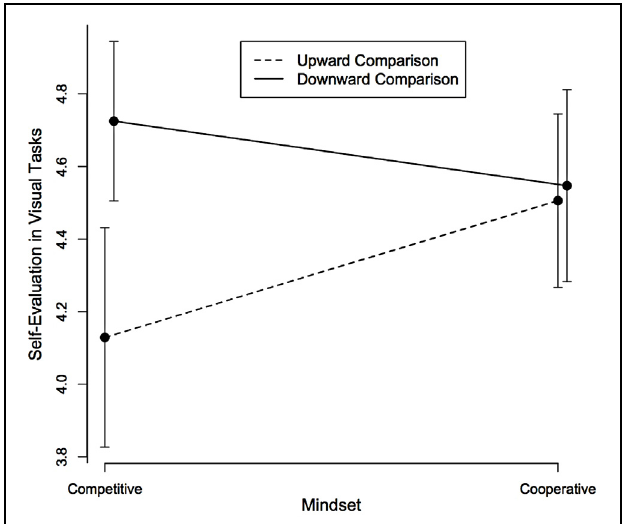
FIGURE 2 | Self-evaluation as a function of the direction of social comparison and the competitive/cooperative mindset. Error bars represent 95% confidence